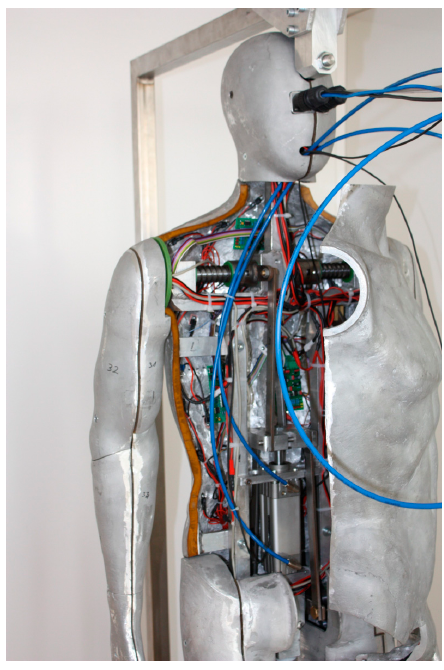
Figure 3. Thermal Figure 3. Thermal manikin.